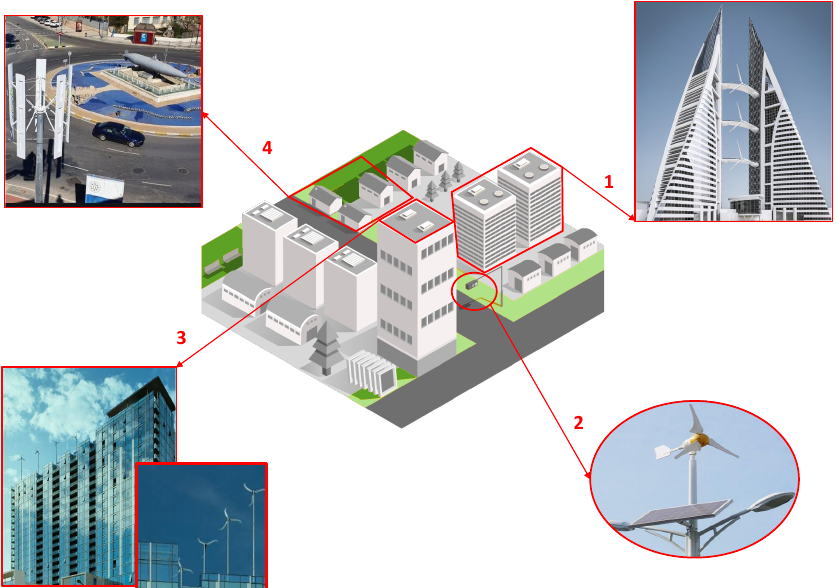
Figure 2. Types of urban wind energy collection systems. Integrated with buildings (1), free standing (2), on the roofs of buildings (3), and alone near buildings (4). Data source: [35–37]. Authors’ own